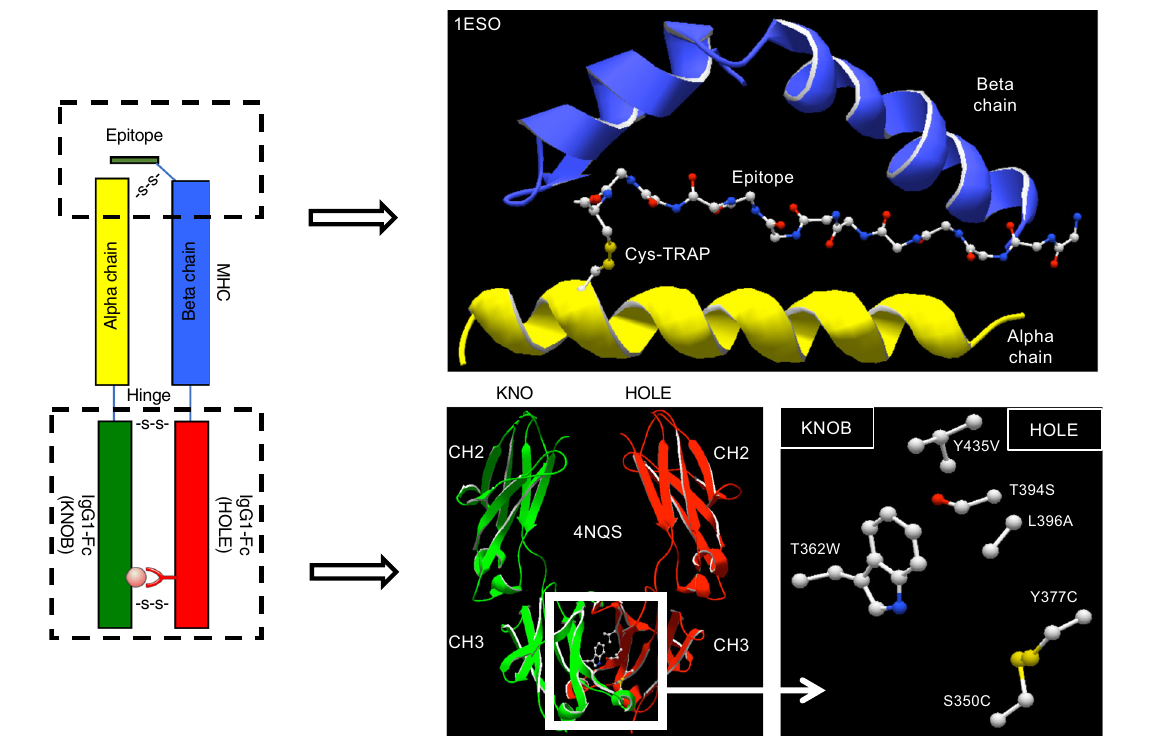
Fig. 4 Cartoons depicting the structure of the KIH-based pMHCII constructs or speci fi c domains. Left: primary structure of a Cys-trapped KIH-based pMHCII heterodimer. Top right: secondary structure of the peptide-binding domain loaded with a peptide bound to the MHCII molecule on a speci fi c register via a disul fi de bridge between the carboxyterminal end of the peptide and a complementary Cys on the MHCII α chain. Bottom right: predicted quaternary structure of the KIH Fc portion of the KIH-based constructs and the key amino acid substitutions that were used to promote KIH-based